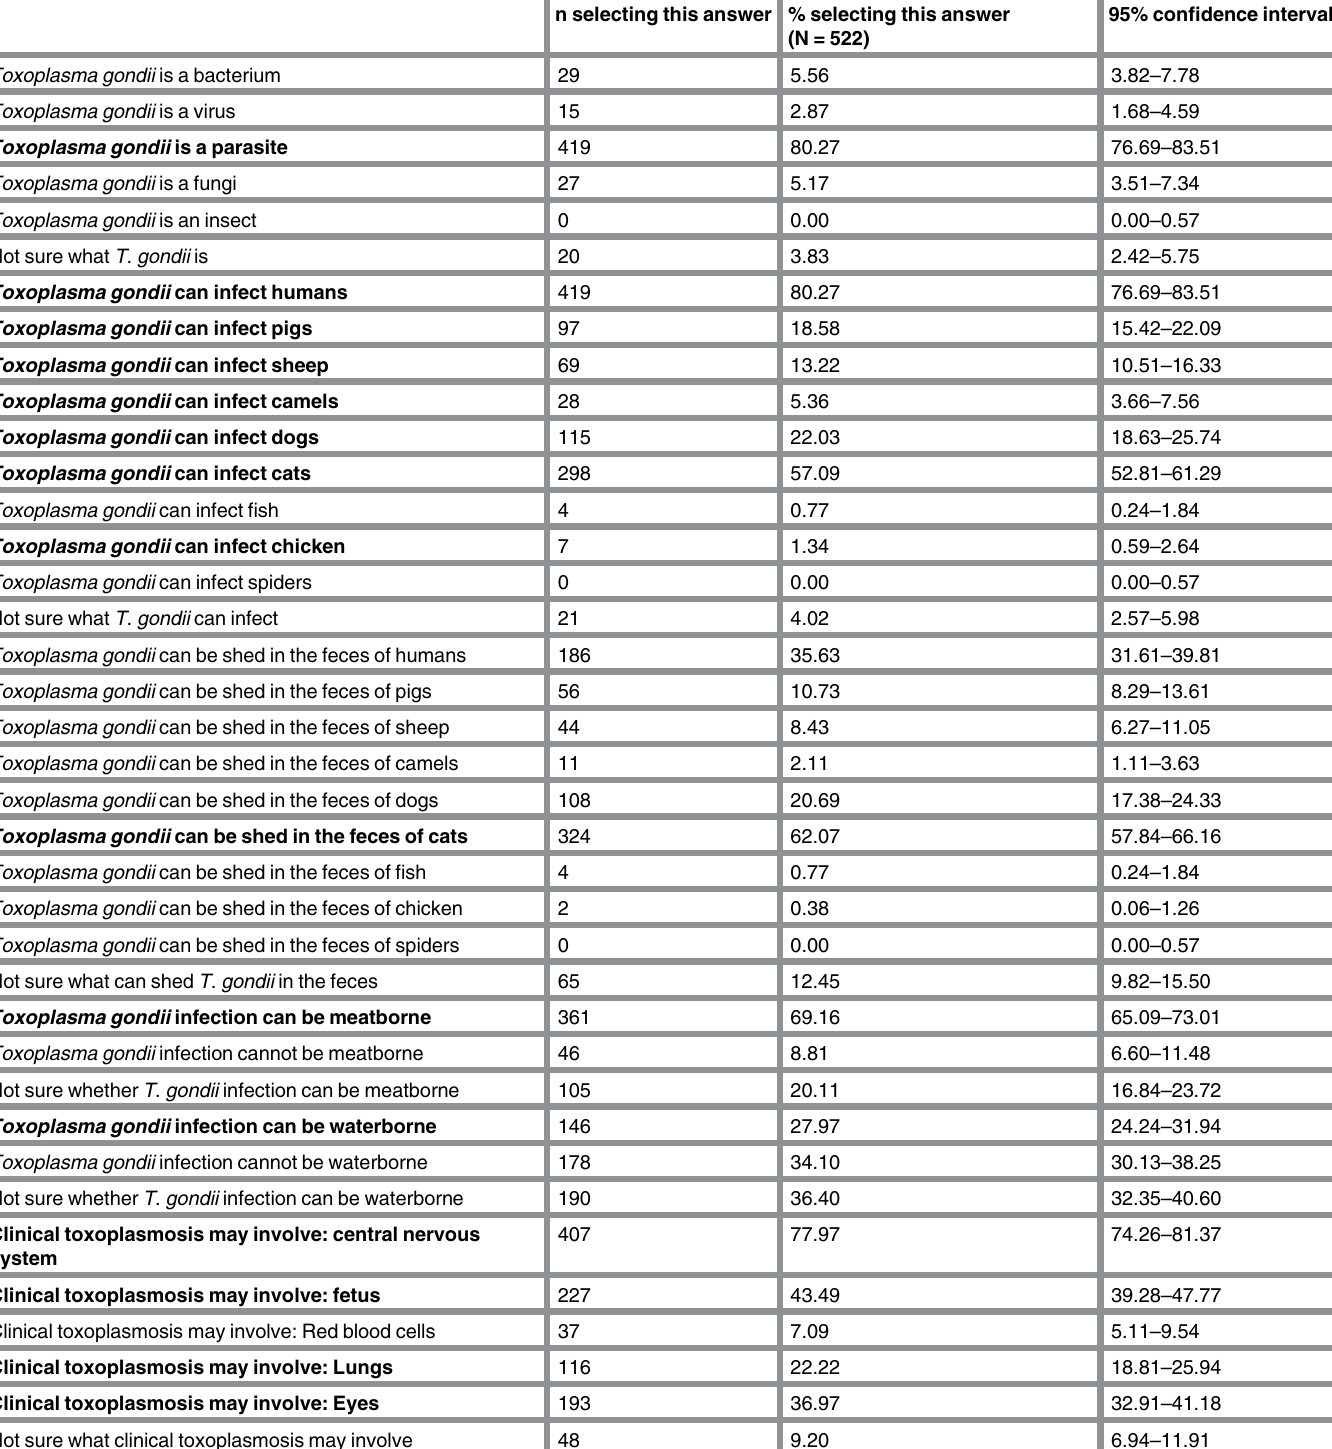
Table 2. Distribution of answersof medical doctors to the knowledge questions on toxoplasmosis. The seventeenanswersthat wereconsidered cor- rect are highlightedwith bold font.